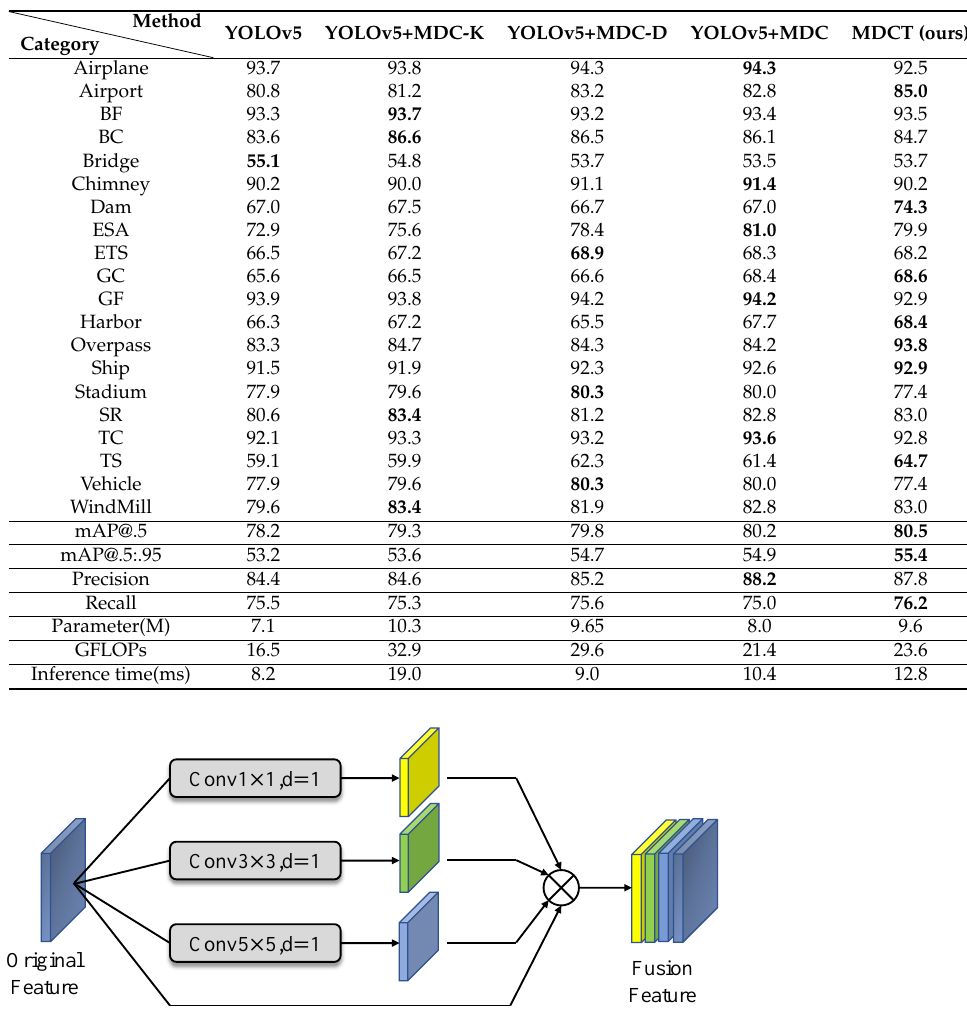
Figure 10. Multiconvolution kernel fusion structure (MDC-K).